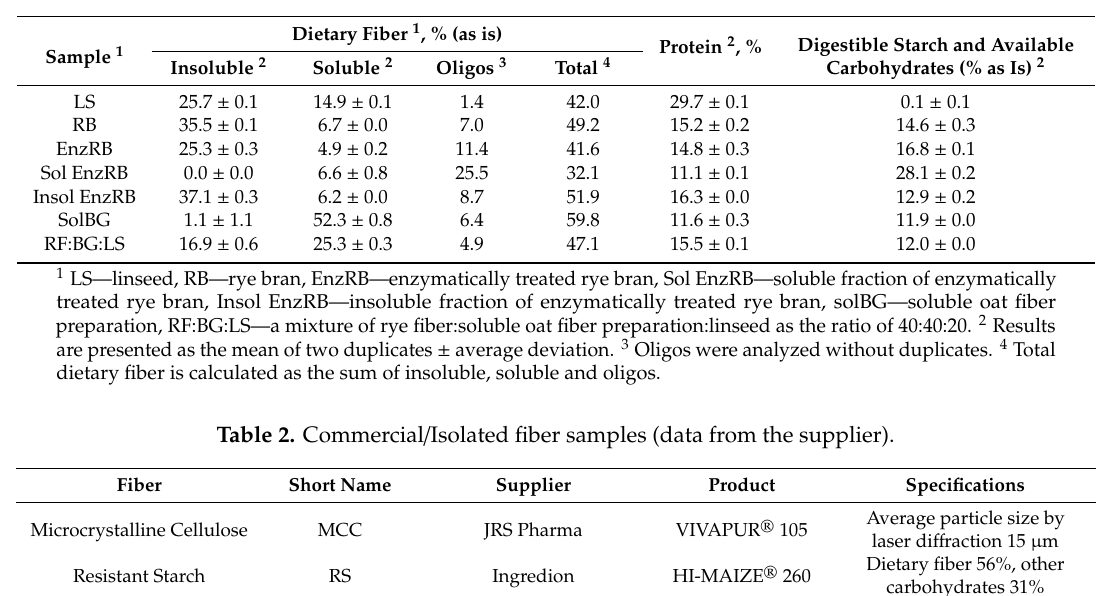
Table 1. The compositions of processed fiber samples.